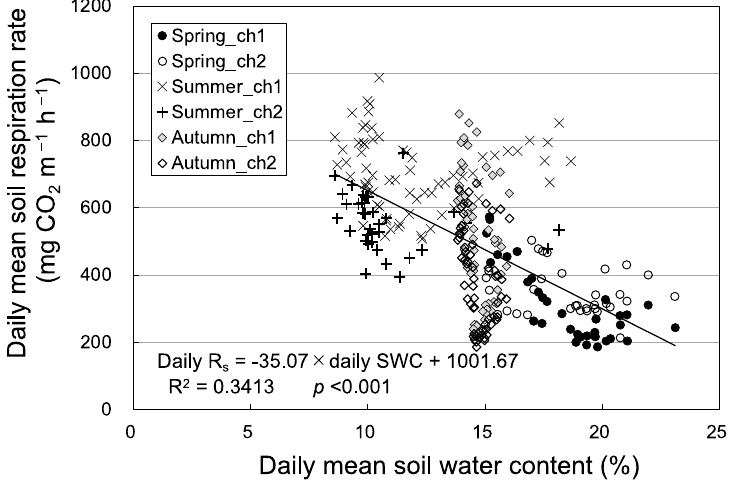
Figure 2. Relationship between soil respiration rate and soil temperature at a depth of 5 cm in the two chambers. Closed black circles, spring; open gray triangles, summer; closed gray circles, autumn.